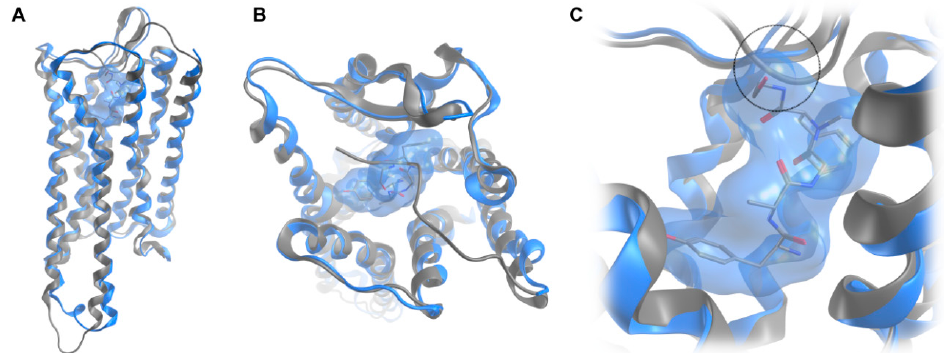
Figure 3. The murine (PDB ID: 5C1M) and the human MOR model differ only in seven amino acid residues as illustrated in red ( A ). Only one of these differing residues is directly pointing to the ligand binding site ( B , grey surface). Whereas a histidine residue is at position 54 in the murine MOR,